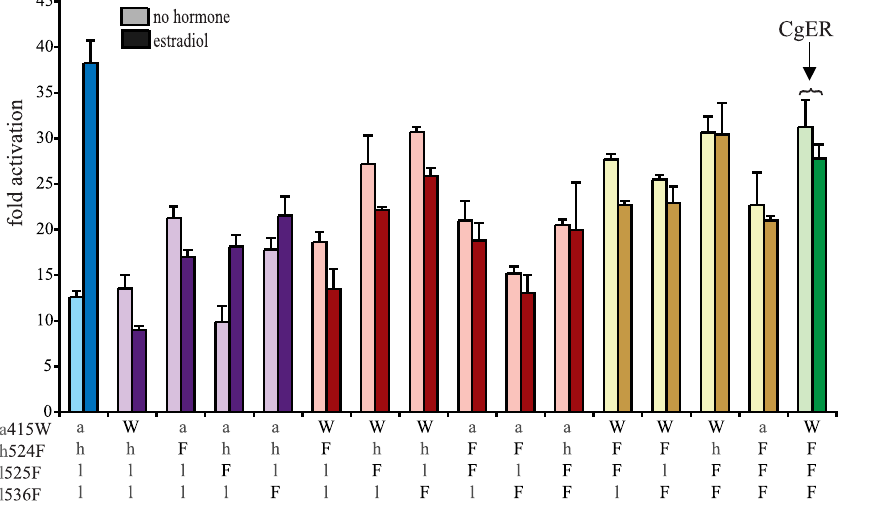
Figure 5. Reversing four historical substitutions in CgER restores estrogen sensitivity. All combinations of derived and ancestral states at the four candidate sites were introduced into CgER and their effects on activation in the presence or absence of hormone was characterized in a luciferase reporter assay. Colors indicate number of residues reversed to ancestral states: green shows the CgER protein (zero ancestral states), yellow (one ancestral state), red (two), purple (three), blue (all four). Lower case letters denote ancestral states; mollusk derived states are shown as upper case.